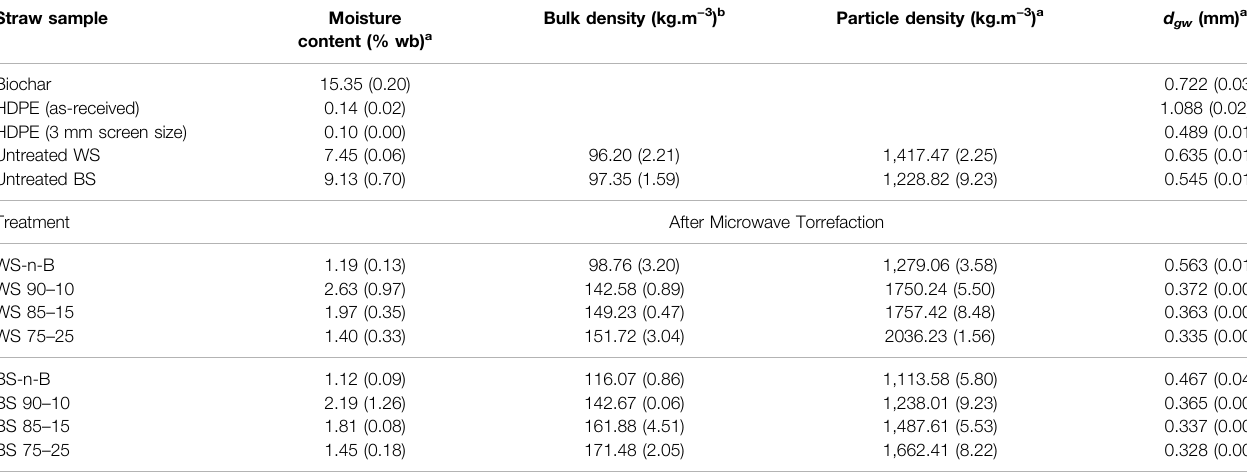
TABLE 1 | Physical characteristics of raw and microwave-torre fi ed wheat and barley straw biochar-mix. Straw sample